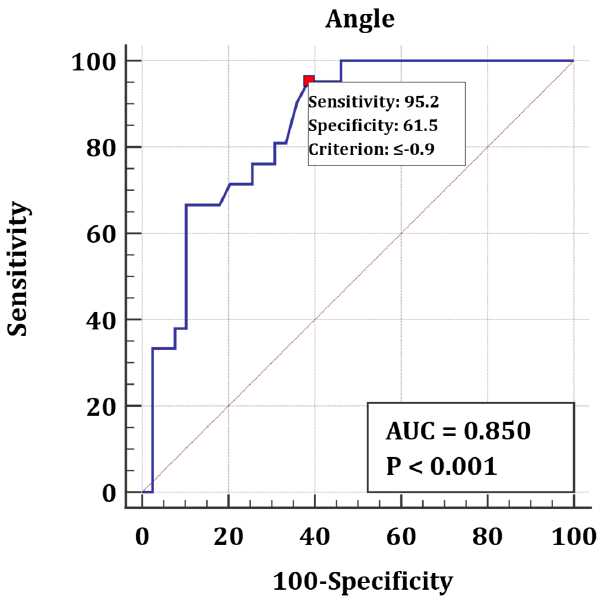
Figure 4. ROC analysis for identification of CLBBB pattern according to rotation angle.